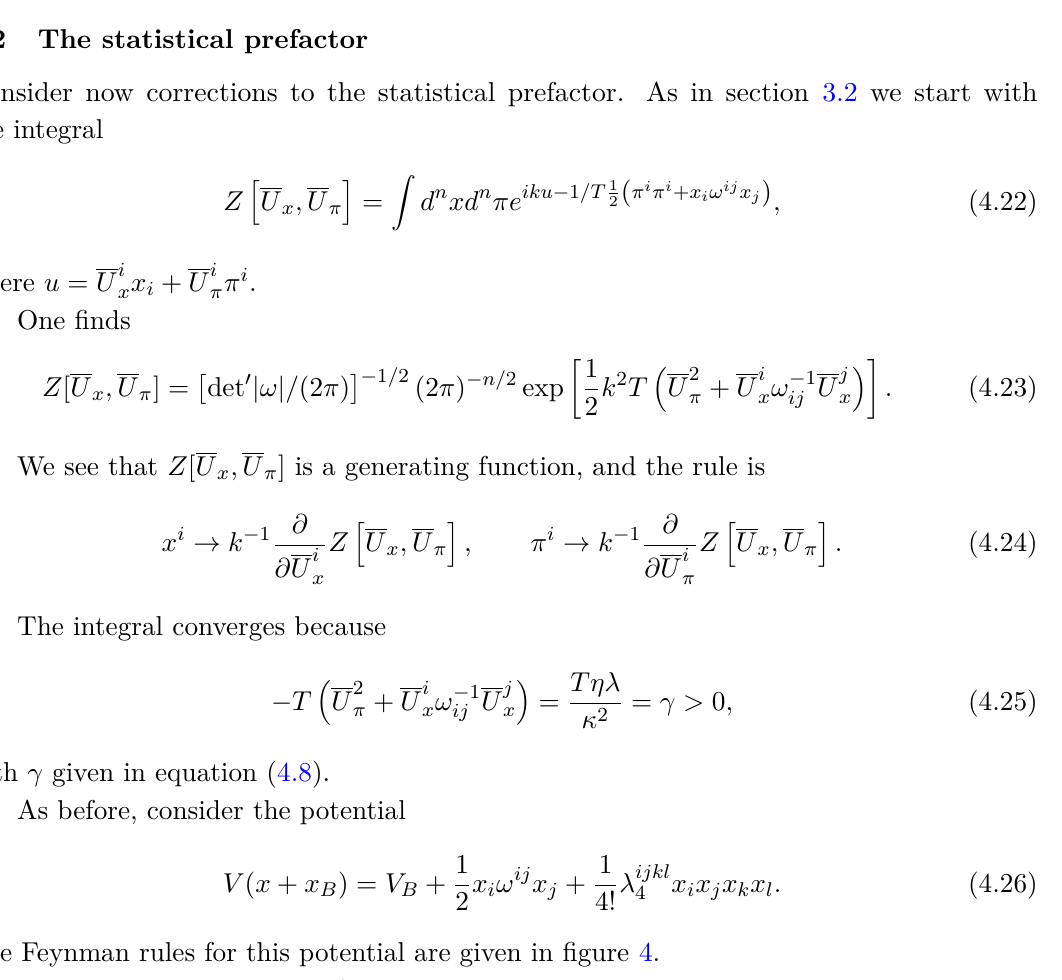
Figure 4 . Feynman rules for general